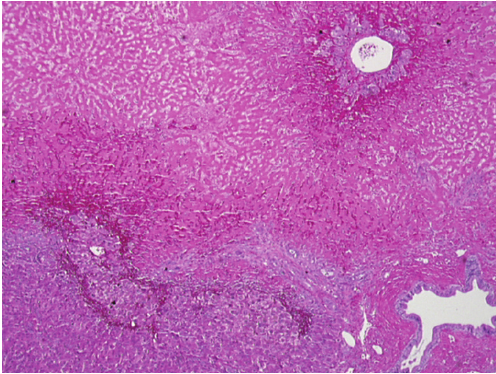
Figure 4: First allograft (400x, H&E section): portal areas show areas of cholangitis. No features of acute cellular rejection. The parenchyma surrrounding this portal area appears viable.